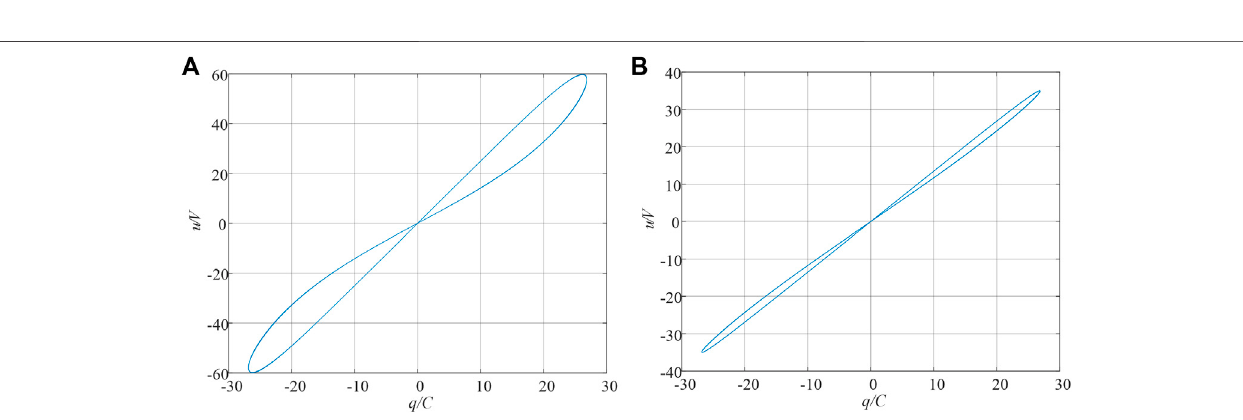
FIGURE 2 | Hysteresis curve of the memcapacitor, (A) c = 1.7, d = 2, f = 10 Hz. (B) c = 1.7, d = 2, f = 80 Hz.